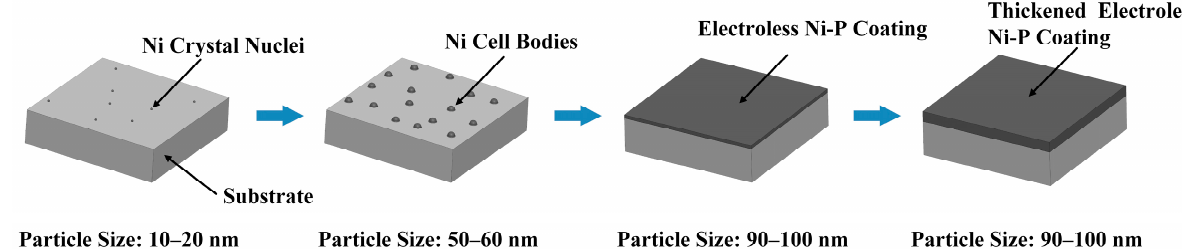
Figure 4. Schematic view of coating growth process.